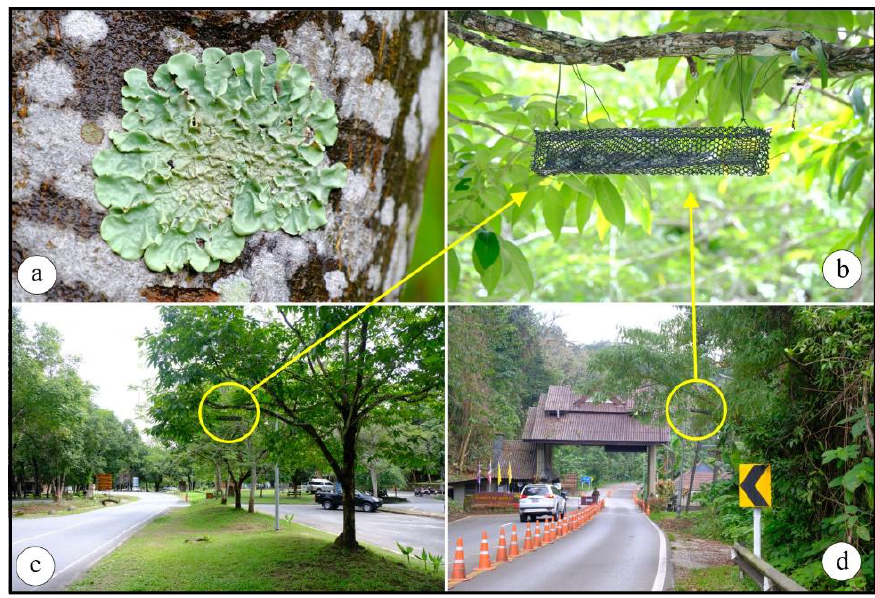
Figure 3. Thallus of the lichen Parmotrema tinctorum ( a ), lichen samples exposed at a monitoring site ( b ), the environment at site KY3 in Khao Yai National Park ( c ) and at site DI3 in Doi Inthanon National Park ( d ). Table 2. Amount of rainfall, number of visitors, and number of vehicles during the study period during the rainy and dry seasons in Khao Yai National Park (KYNP) and Doi Inthanon National Park (DINP).